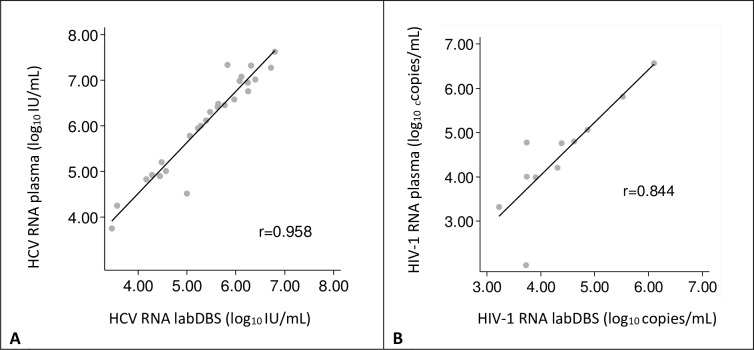
Correlation between laboratory sampled dried blood spots (labDBS) and plasma viral load measurements.Individual viral load measurements are plotted (gray dots). The solid line indicates the linear regression line between the two samples. (A) HCV loads. The linear relationship between the samples is defined as: log10 IU/mL plasma HCV = 1.119 x (log10 IU/mL labDBS) + 0.036. (B) HIV-1 loads. The linear relationship between the samples is defined as: log10 copies/mL plasma HIV-1 = 1.193 x (log10 copies/mL labDBS) - 0.738.